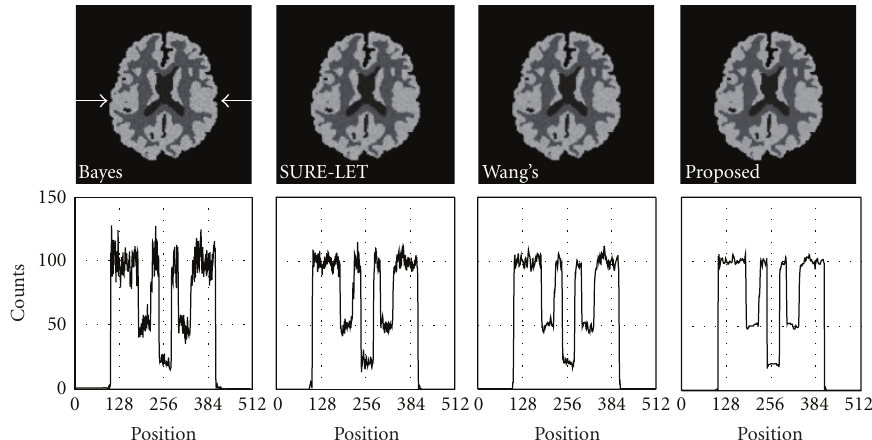
Figure 4: Denoised image of the brain phantom. From left to right, BayesShrink, SURE-LET, Wang’s method, and our proposed method. The profile along a line indicated with two arrows is shown below each image.